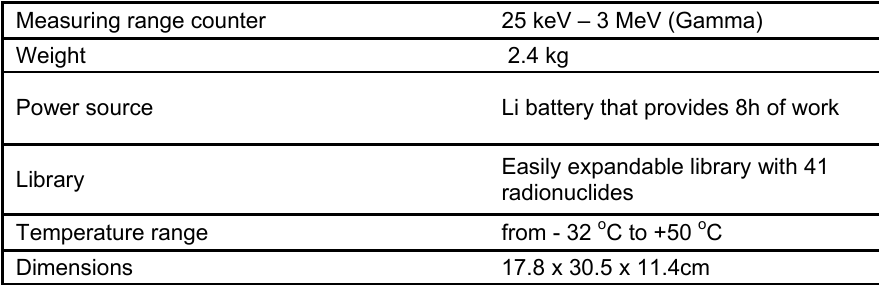
Table 1 – Technical features of the